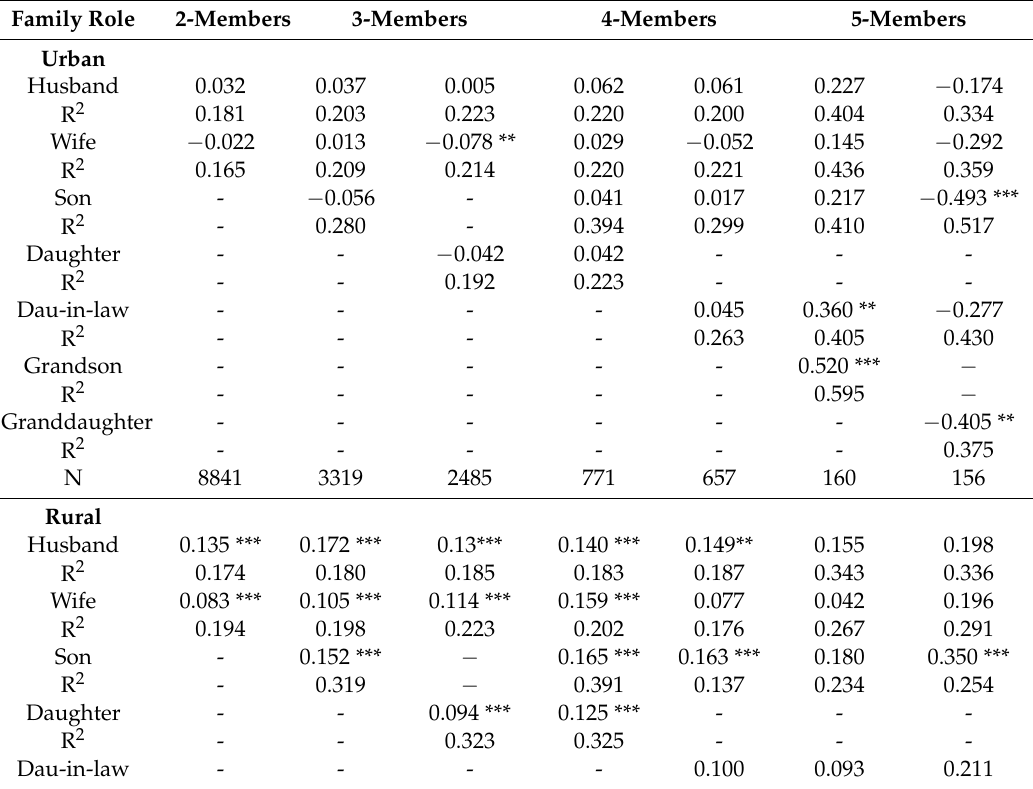
Table A3. FDI and food price interaction term results (dependent variable: ln individual calorie). Family